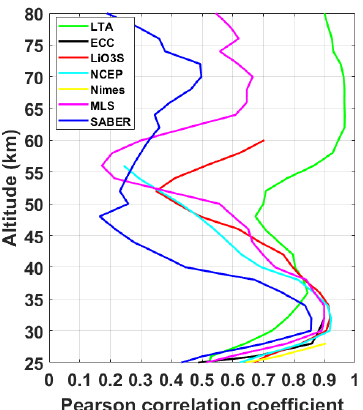
Figure 17. Vertical profiles of the correlation between temperatures reported by the various LAVANDE systems and temperature mea- sured by NASA STROZ. Outliers were excluded. Correlation is taken over the 28 nights of LAVANDE, and over 2km in altitude. For MLS and SABER, correlations are given for the weighted aver- age